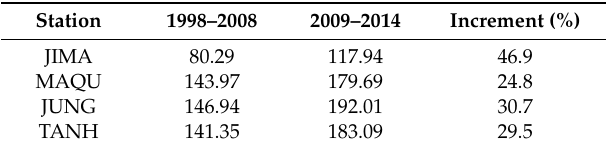
Table 7. Mean annual runo ff (mm) at 4 hydrometric stations in two